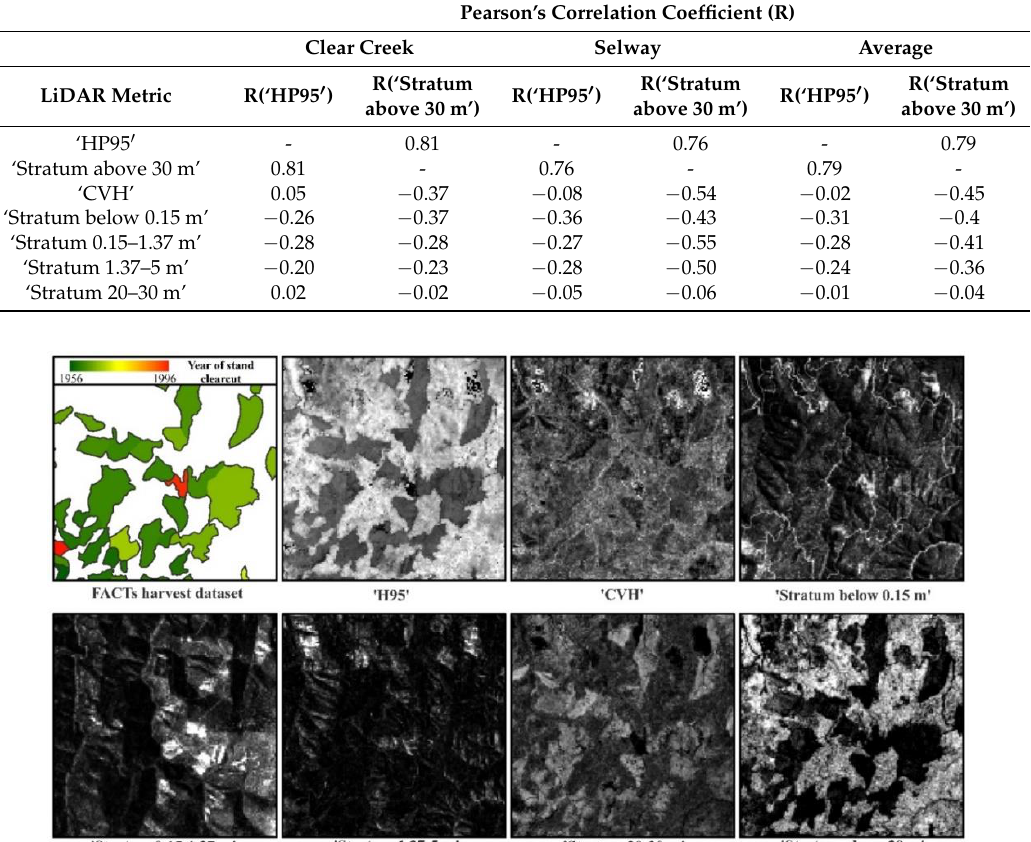
Table 2. LiDAR metrics considered in the analysis. The ‘H95′ and ‘Stratum above 30 m’ metrics were selected based on literature review. From the remaining 34 metrics, the five metrics with absolute average value of the Pearson’s correlation coefficient of the two LiDAR datasets (i.e., Clear Creek and Selway) lower than 0.5 (i.e., |R| < 0.5) with both ‘H95′ and ‘Stratum above 30 m’ were selected.